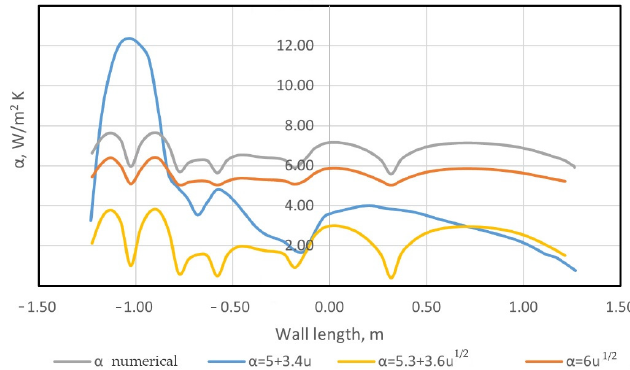
Figure 24. Heat transfer coefficients for the right wall 𝛼 𝑖𝑛 .